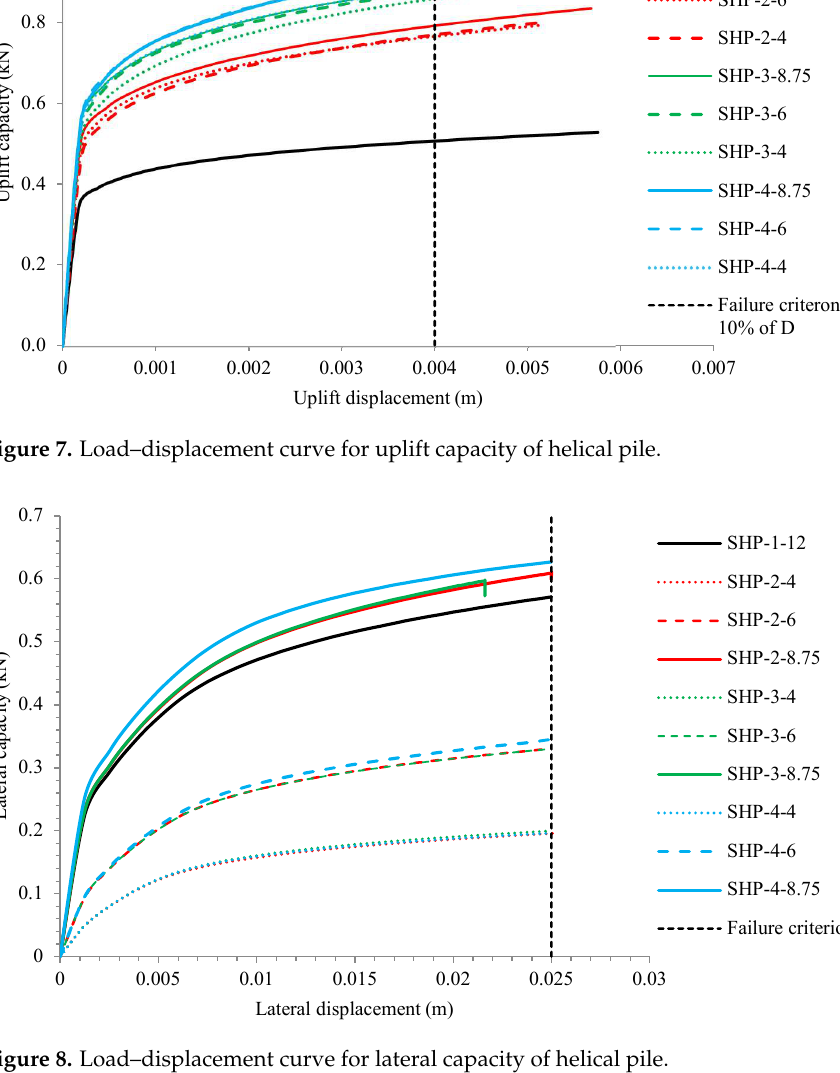
Table 3. Theoretical, numerical, and experimental results of uplift and lateral capacity.